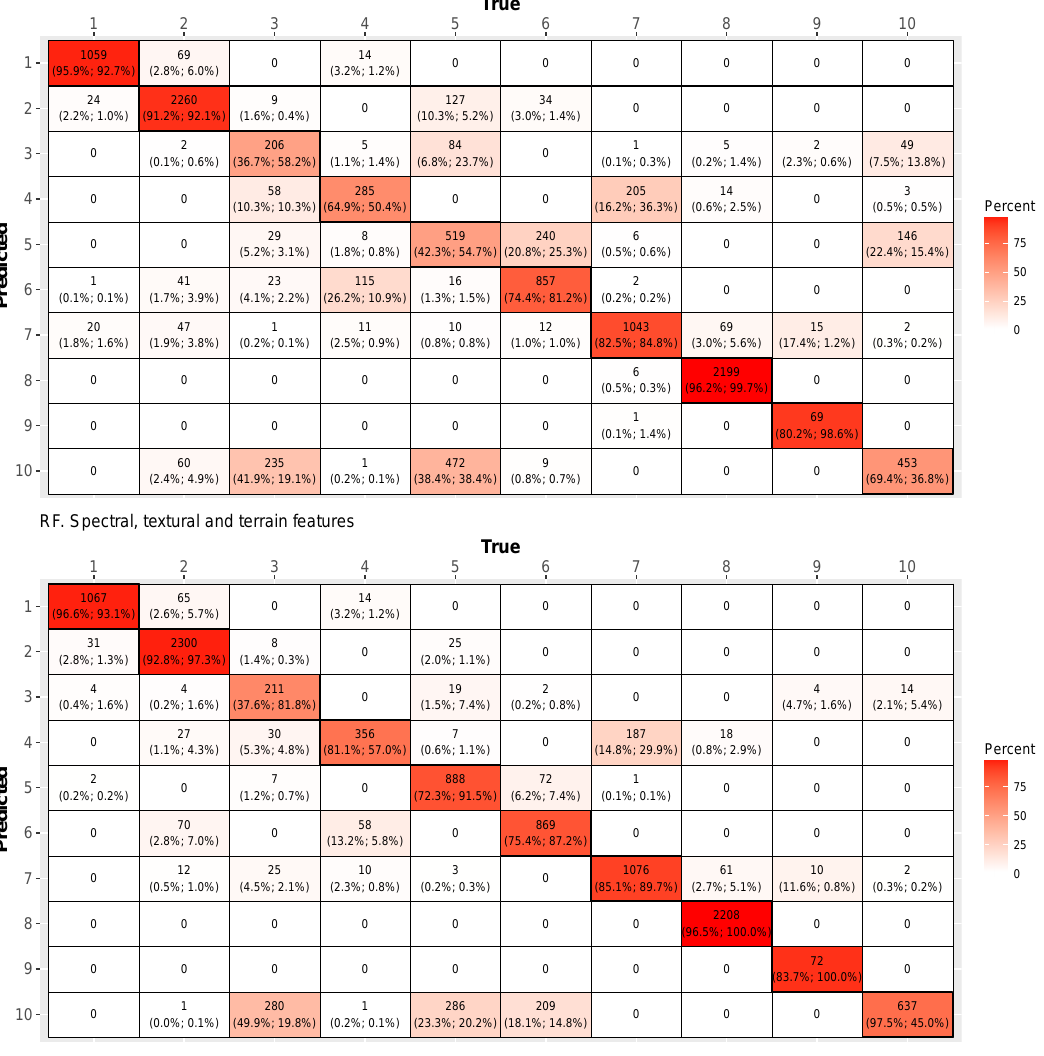
Figure 10. Four-season confusion matrix in 2015 using spectral and textural features (top) and spectral, textural and terrain features (bottom) with RF algorithm. The number of correctly classified pixels and the producer’s (left) and user’s (right) accuracy values appear in the diagonal. Outside the diagonal appear the number of confusions, the percentage of the column class incorrectly classified as the row class (left) and the percentage of the row class that truly belongs to the column class